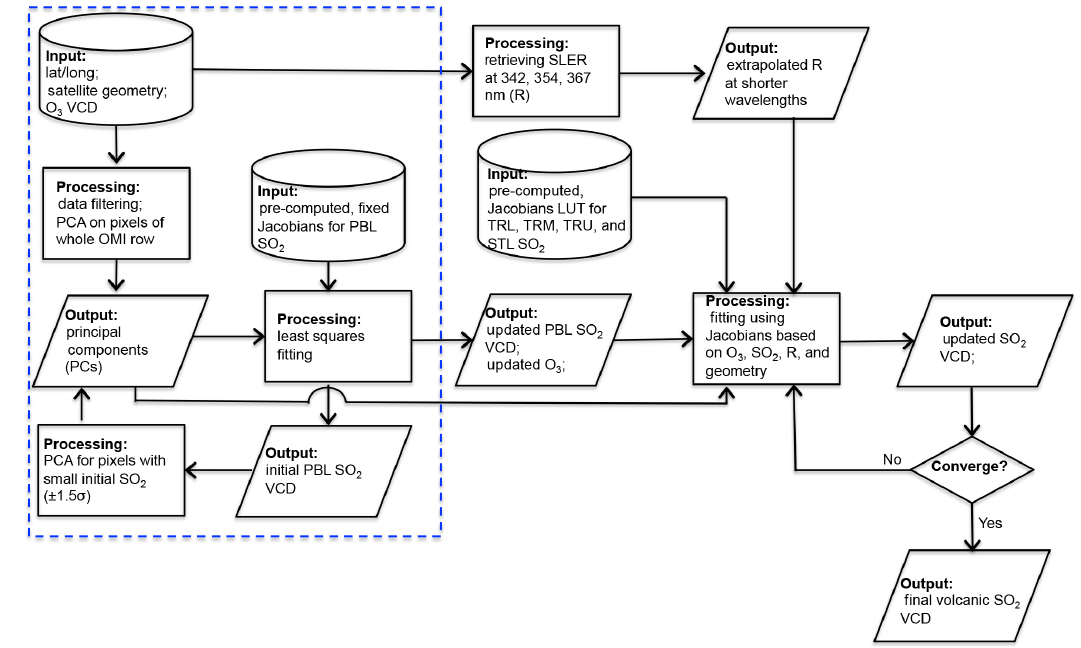
Figure 1. A flow chart of the new OMI volcanic SO 2 PCA retrieval algorithm (OMSO2VOLCANO). The first part of the algorithm, enclosed in the dashed blue box, is essentially identical to the operational OMI planetary boundary layer (PBL) SO 2 algorithm (Li et al., 2013) and provides input to the second part of algorithm that performs iterative spectral fitting to retrieve volcanic SO 2